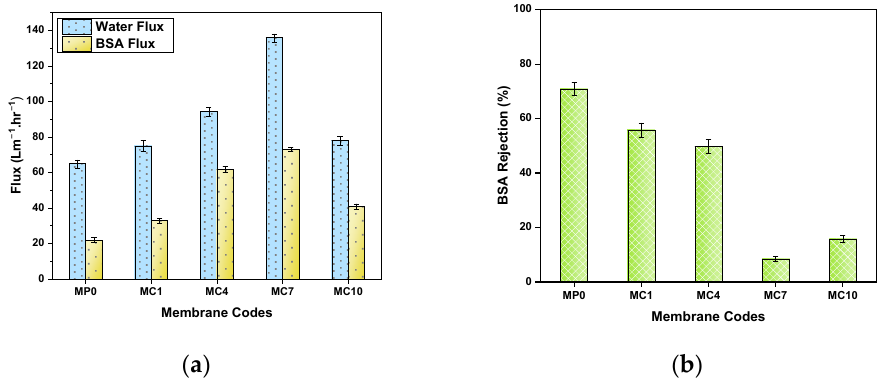
Figure 13. Studies of the performance of the fabricated membranes of the pristine and mAC membranes: ( a ) Water and BSA flux rates; ( b ) BSA rejection (%).